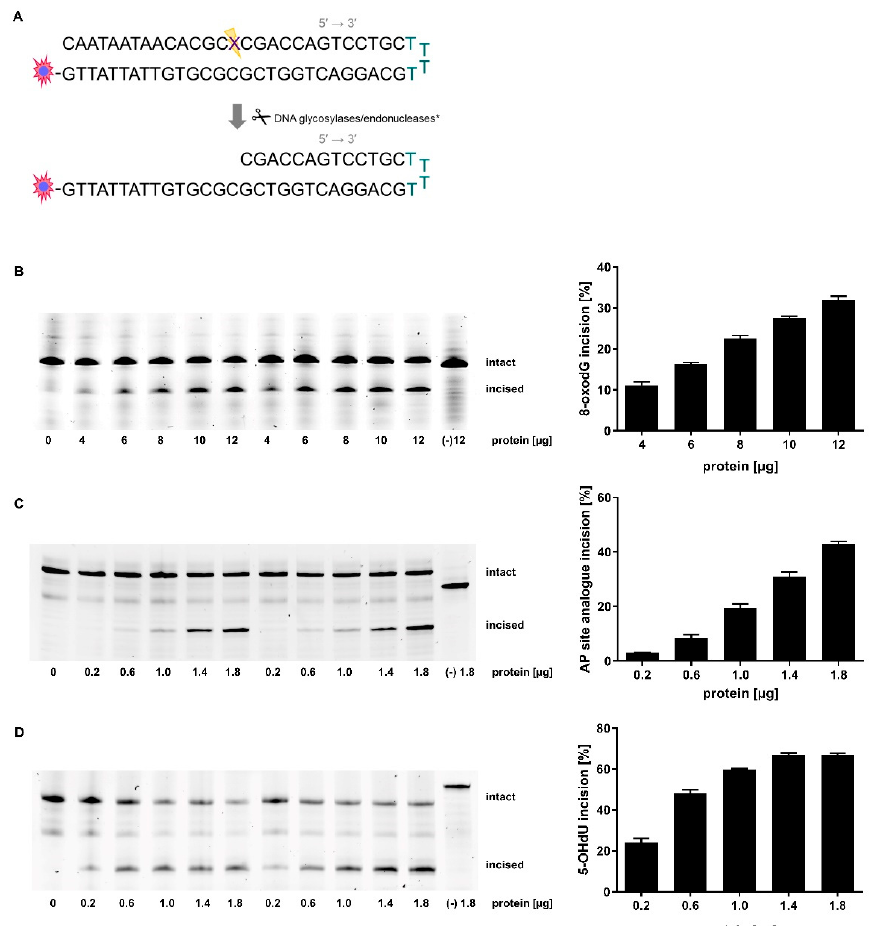
Figure 1. Incision activity assay. Schematically shown is the 3’ Cy5-labelled oligonucleotide base sequence of the 8-oxodG / AP site analogue containing oligonucleotide in hairpin structure (5-OHdU containing oligonucleotide slightly di ff ering) before and after lesion incision ( A ). Major relevant DNA glycosylases / endonucleases (*) for lesion (X) incision: X = 8-oxodG → OGG1 ( + APE1), X = AP site analogue → APE1, X = 5-OHdU → NEIL1 / 2 ( + polynucleotide kinase) / NTH1 ( + APE1). Incision activity of di ff erent amounts of tissue extract protein was assessed towards ( B ) the 8-oxodG, ( C ) the AP site analogue, and ( D ) the 5-OHdU containing oligonucleotide by fluorescence detection (full-length gels are shown in Figure S3). Shown are polyacrylamide gels (left, 2 replicates of each applied protein amount are shown) and mean values + SEM ( n = 4 (technical replicates of one animal)) of corresponding quantified BER incision activity (right). Quantification was performed by analysis of percentage of incised (lower band) versus intact (upper band) oligonucleotide for each lane. As negative control for each oligonucleotide with a DNA lesion, a damage-free oligonucleotide with the respective base sequence and the correct pairing base (G instead of 8-oxodG and the AP site analogue; C instead of 5-OHdU; marked as (-)) was designed and incubated according to the assay protocol with tissue extract protein.